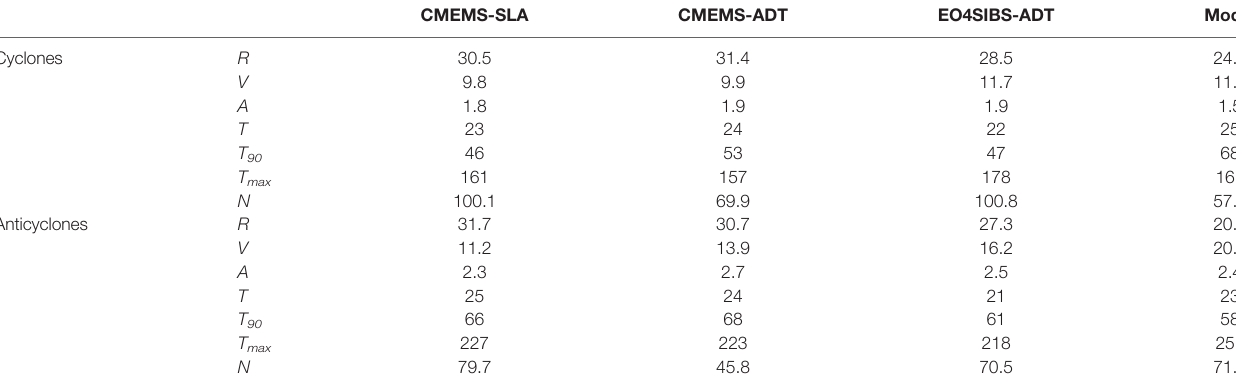
TABLE 2 | Eddy properties obtained from the different altimetric products and the model